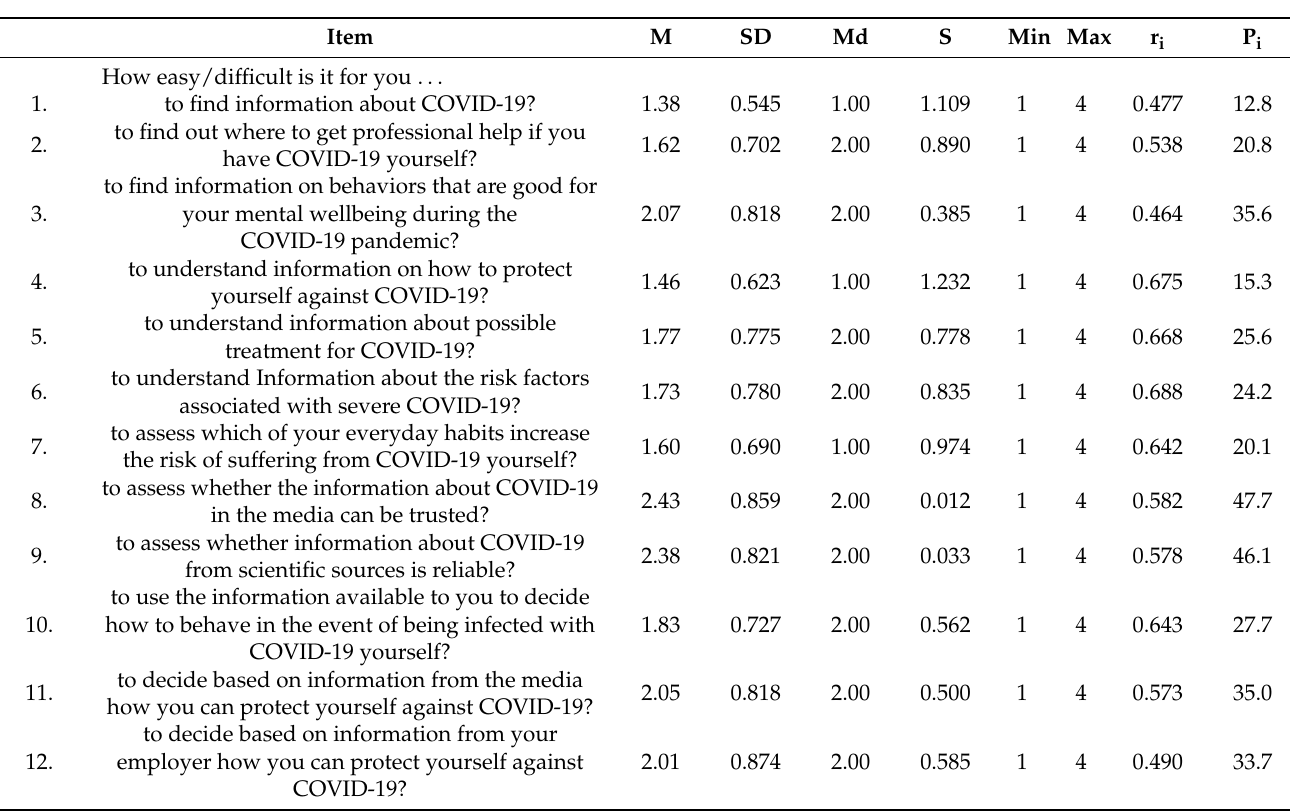
Table 2. HL-COV-HP